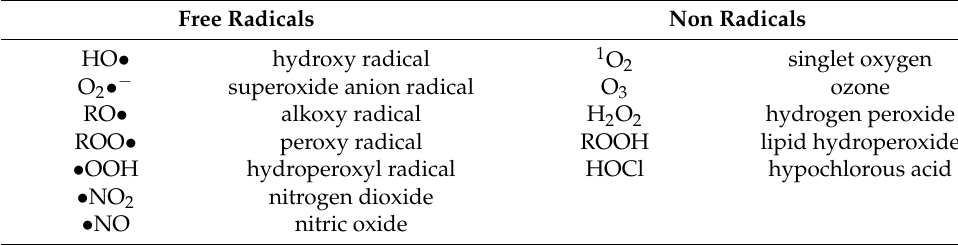
Figure 1. Schematic diagram of ferroptosis. Table 2. Classification of reactive oxygen